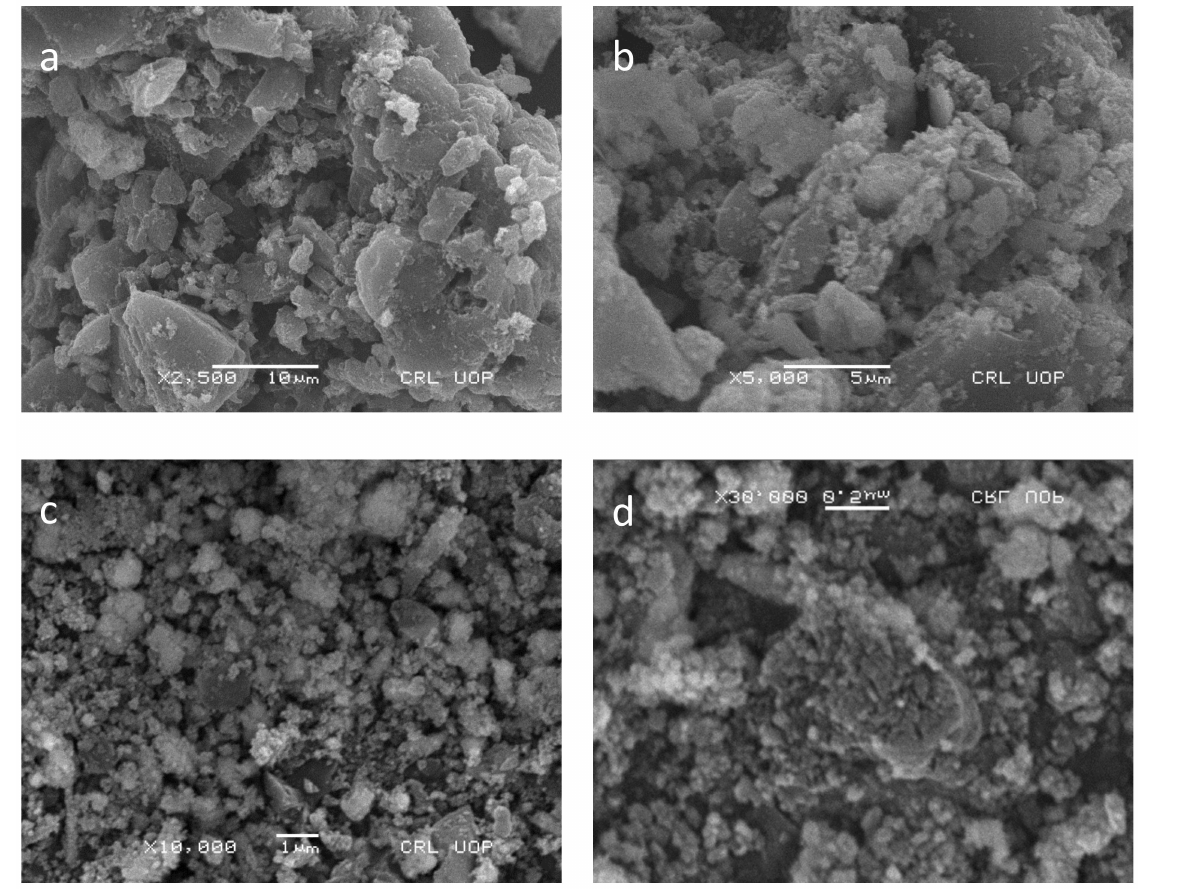
Figure 3. SEM images of Pd–Ni supported on activated carbon at different magnifications of ( a ) 5000 × , ( b ) 10,000 × , ( c ) 30,000 × , ( d ) 2500 ×